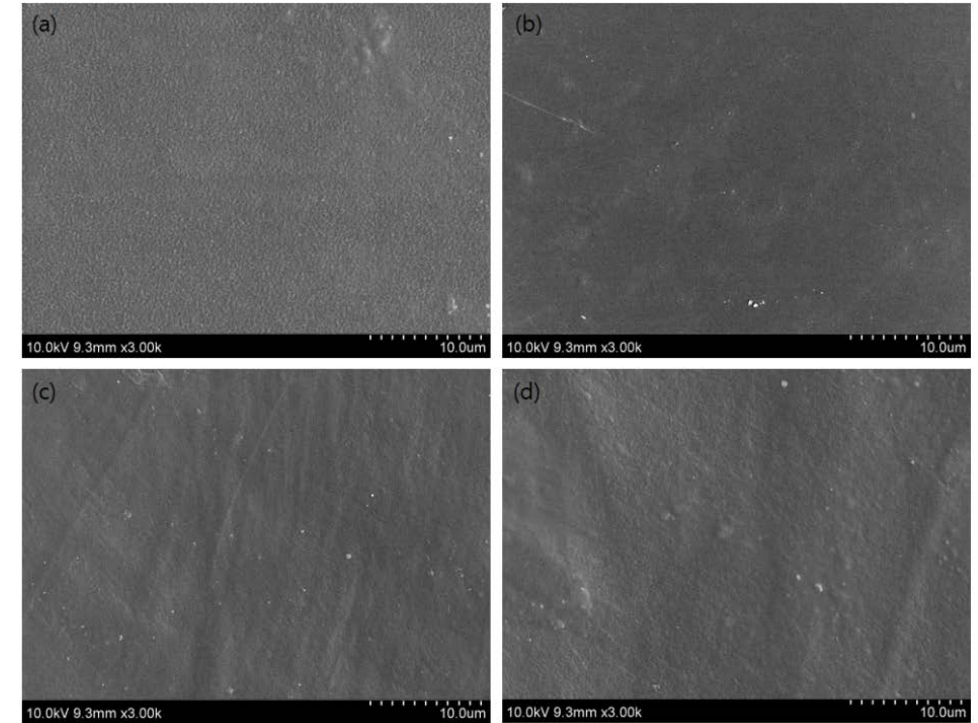
Figure 6. SEM images of composites having: ( a ) only CP, ( b ) 1:0.5 CP/PU, ( c) 1:1 CP/PU, and ( d ) 1:1 CP/PU with 10 wt% curcumin.